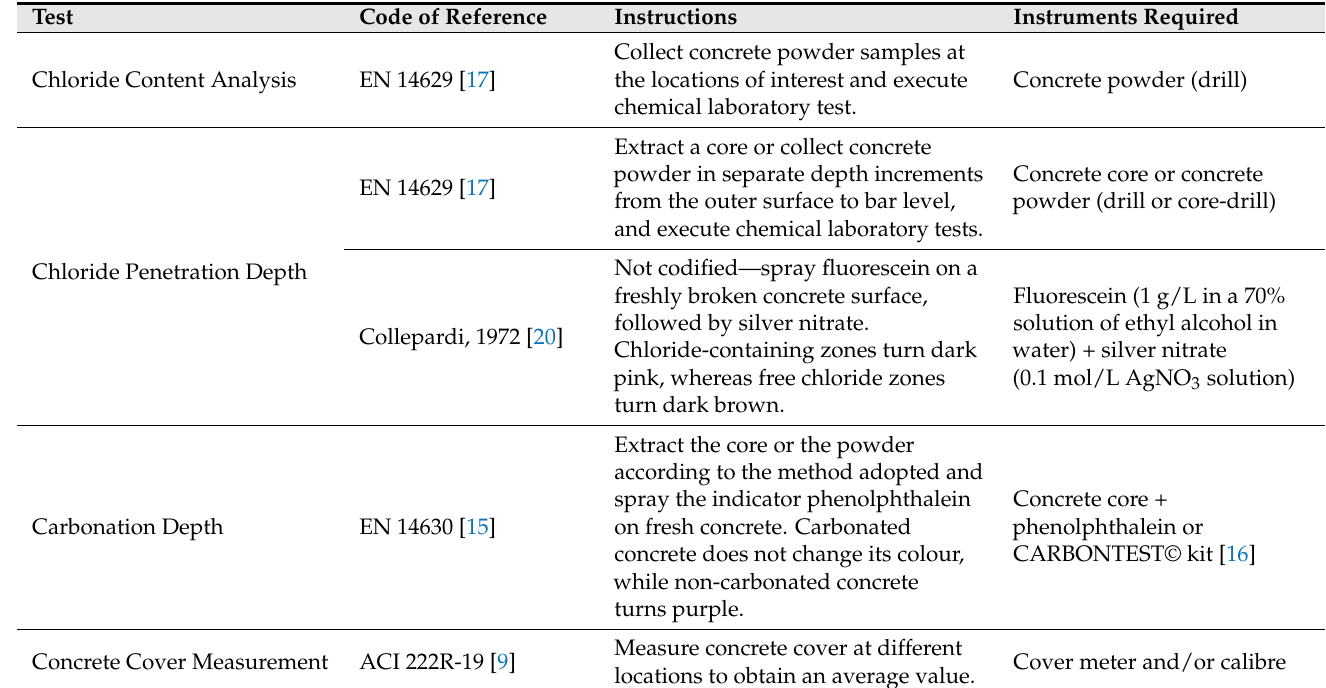
Table 5. Test required for the scenario identification procedure: description and codes of